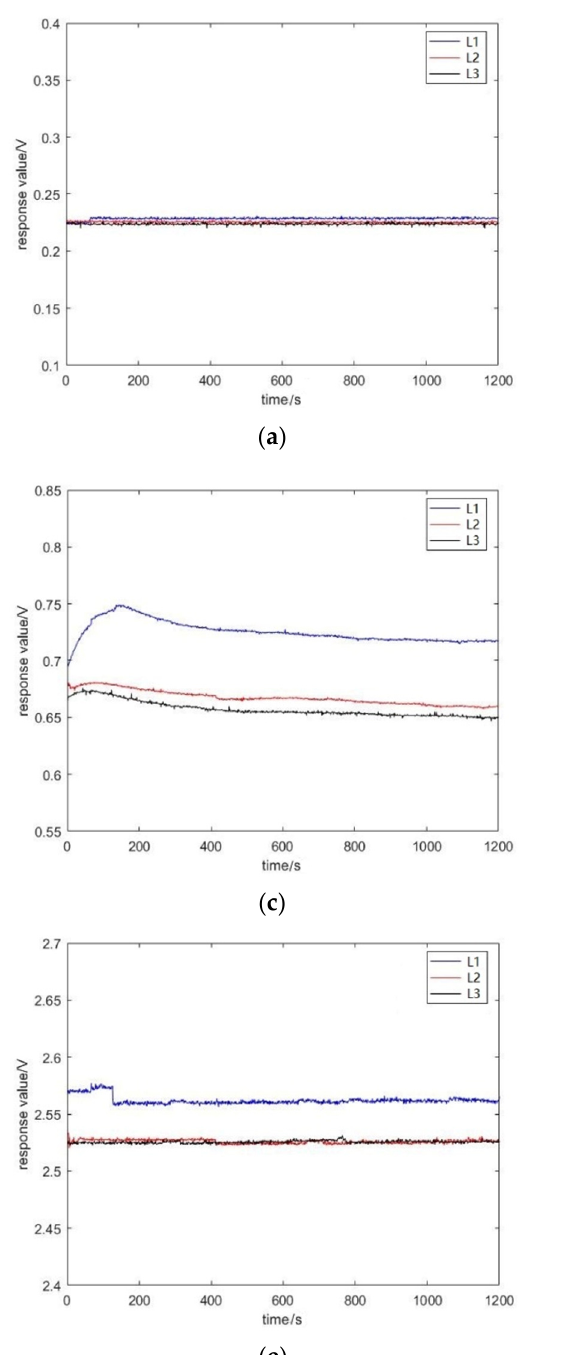
Figure 9. The sensor response values of L1 apple quality with time.